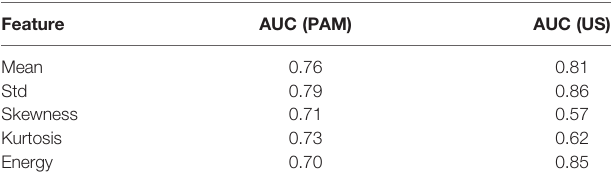
TABLE 2 | AUCs of the fi tted regression model developed using features of PAM and US images. Feature